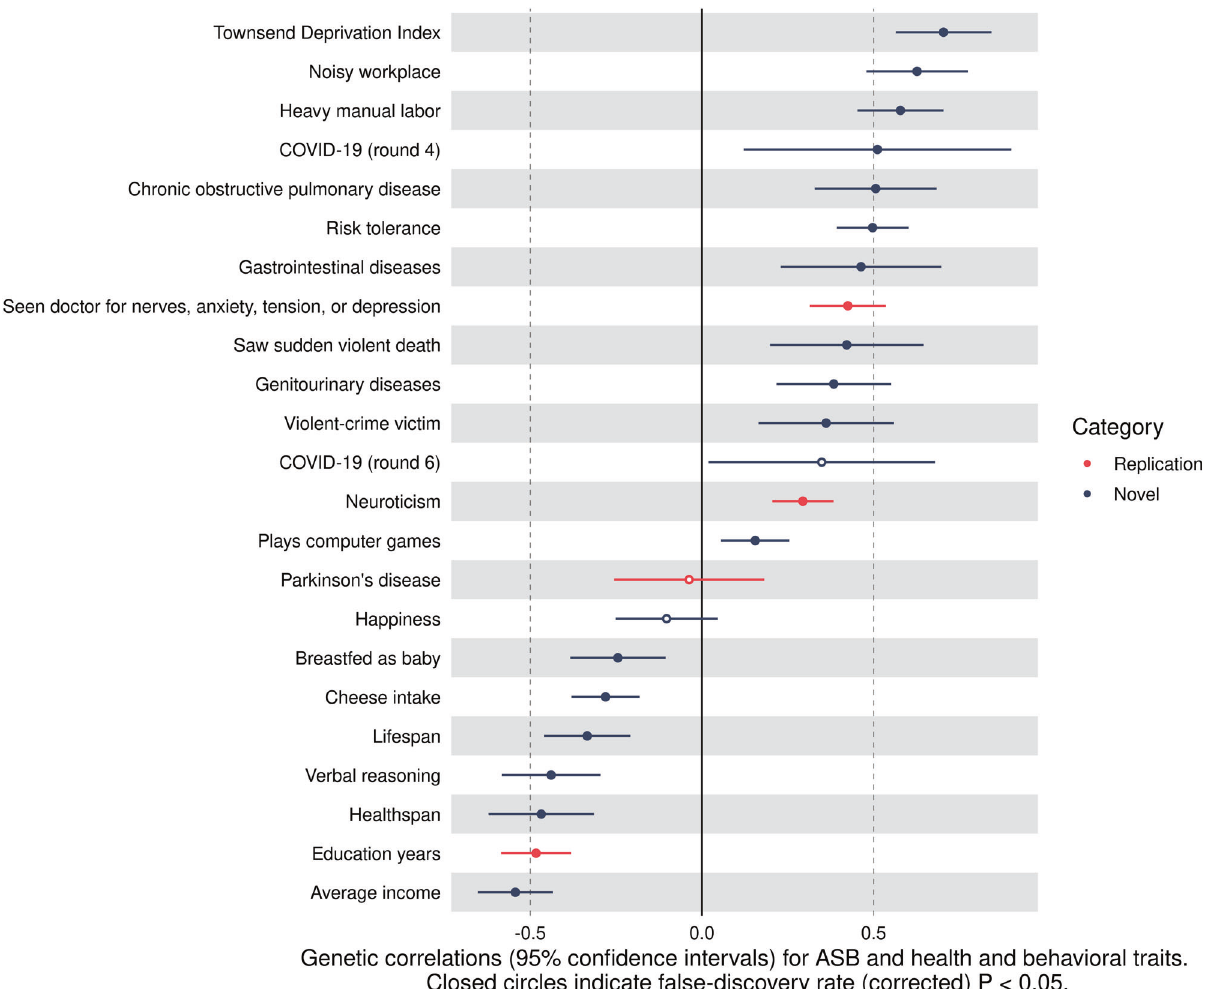
Fig. 1 Genetic correlations and 95% con fi dence intervals for ASB and health and behavioral traits. Closed circles indicate false-discovery rate (corrected) P -values